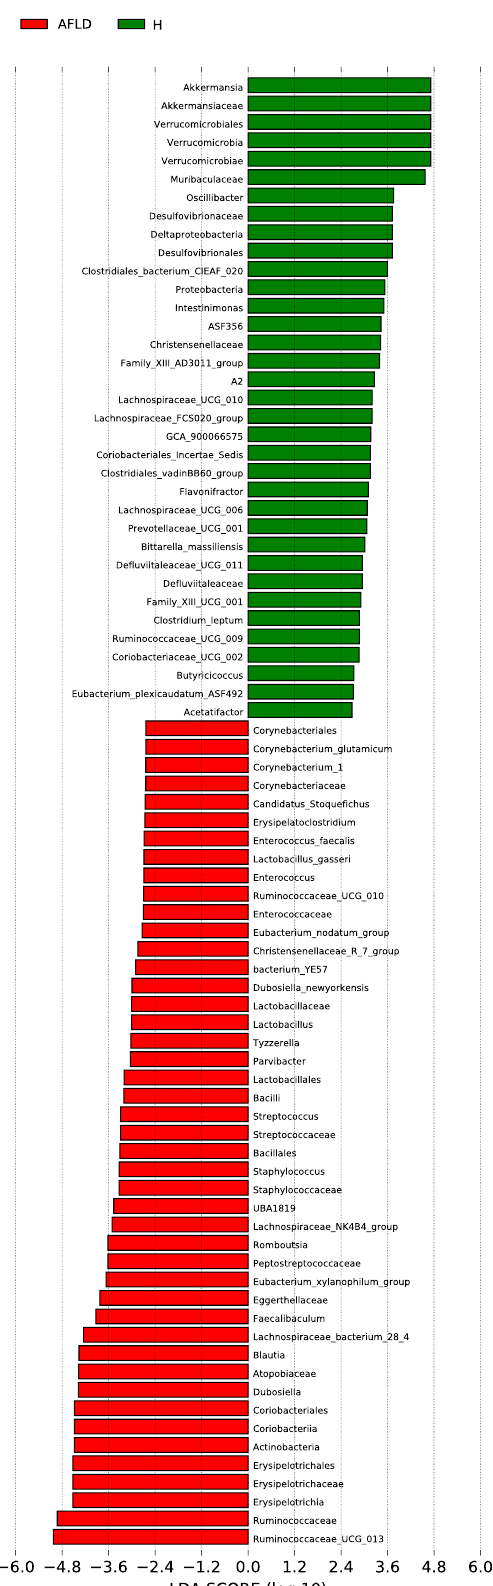
Figure 5. The LDA distribution chart, generated from LEfSe, shows the most differentially abundant taxa in the intestinal microbiota, ranging from phylum to genus (LDA score > 4). AFLD (red): the model group; H (green): high concentration of DOFE.